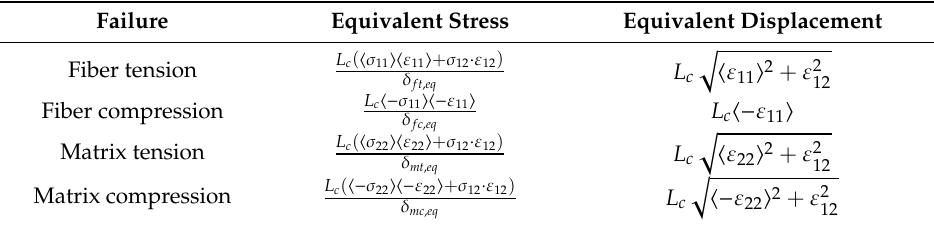
Table 1. Equivalent stress and displacement definitions.